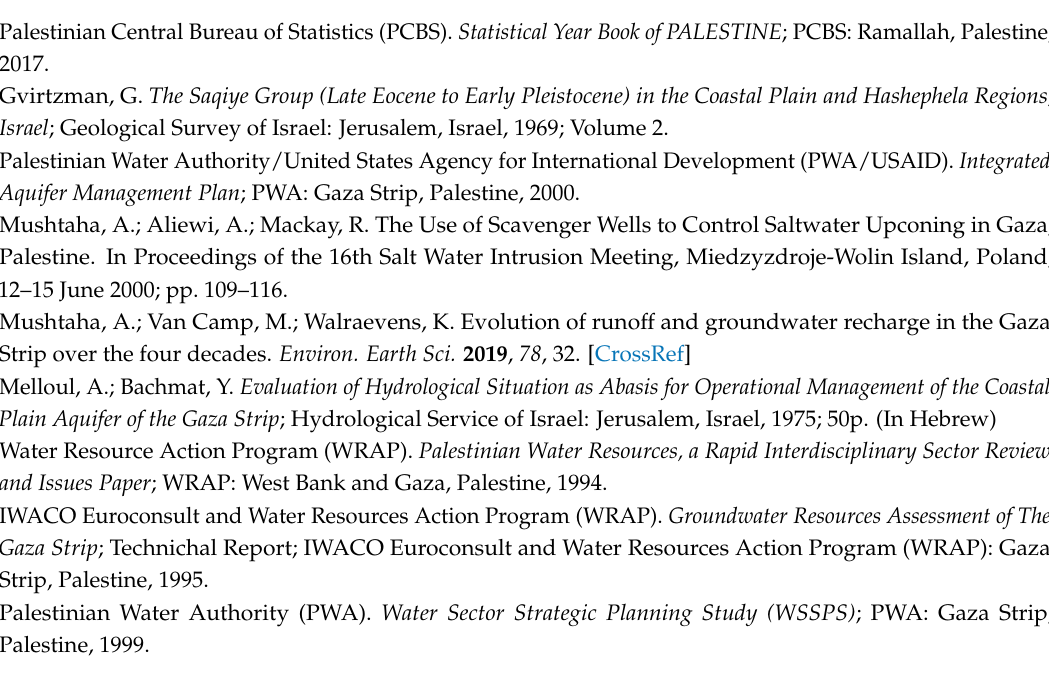
Figure S1: Soil texture map, Figure S2: Rainfall stations location, Figure S3: Land use maps in different years, FigureS4: Screen shoot for developed new GIS tool for runoff and recharge estimations, Figure S5: Spatial distribution of runoff in 1935, Figure S6: Spatial distribution of recharge in 1935, Figure S7: Recharge and runoff for selected years with rainfall less than long term average (326 mm), Figure S8: Recharge and runoff for selected years with rainfall greater than long term average (326 mm), Annex I: Runoff GRID maps (1973 to 2016), Annex II: Recharge GRID maps (1973 to